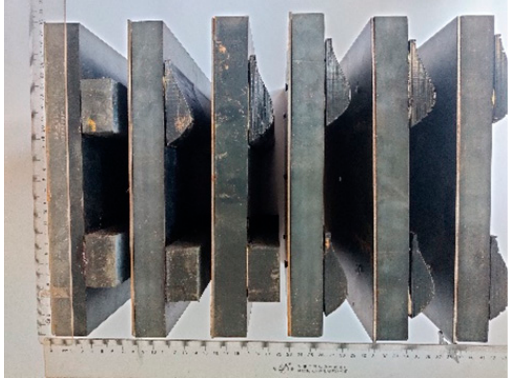
Figure 9. Specimens of track shoe.